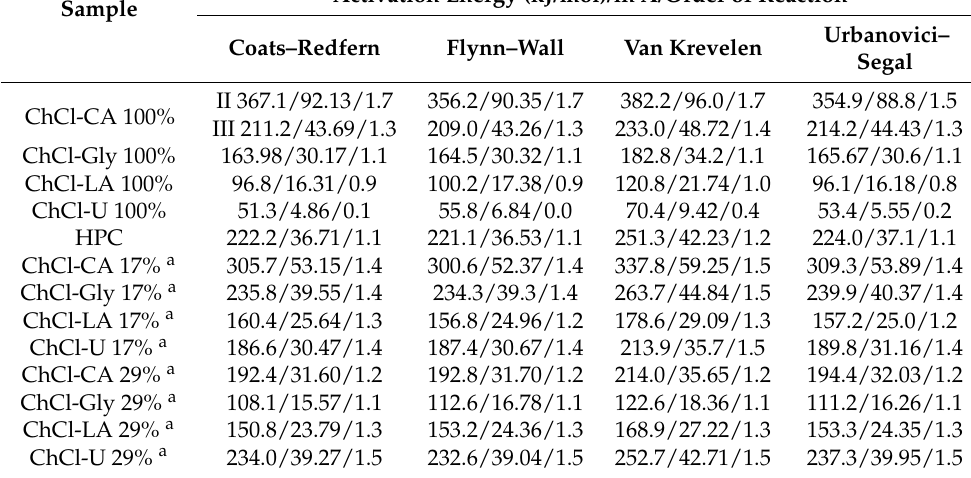
Table 3. Kinetic parameters of thermal degradation of HPC, NADES and HPC-NADES gels (17 and 29% w / w